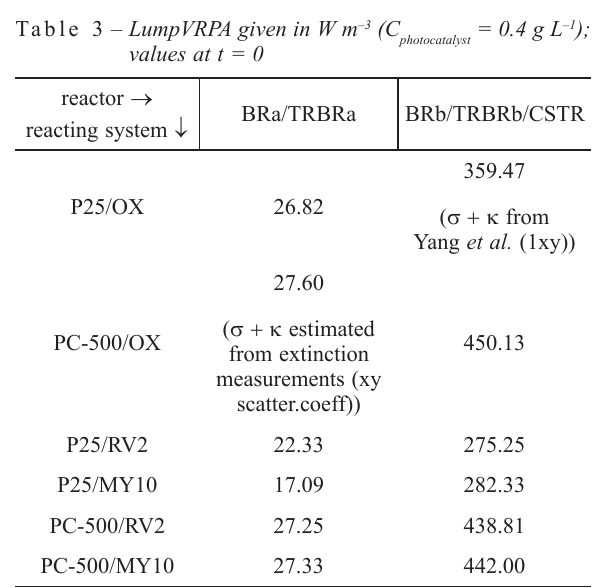
Table 3 – LumpVRPA given in W m –3 (C